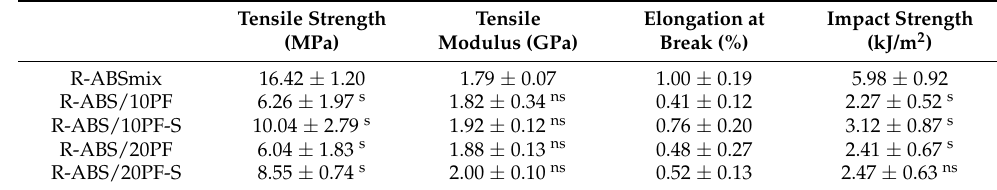
Table 5. Mechanical properties of the palmyra fiber composites and